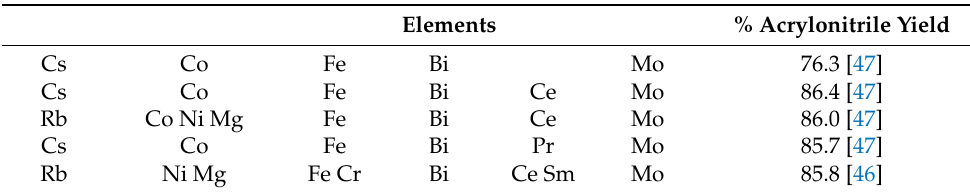
Table 3. Examples of cerium in high-performing silica-supported industrial acrylonitrile oxide catalyst formulations.